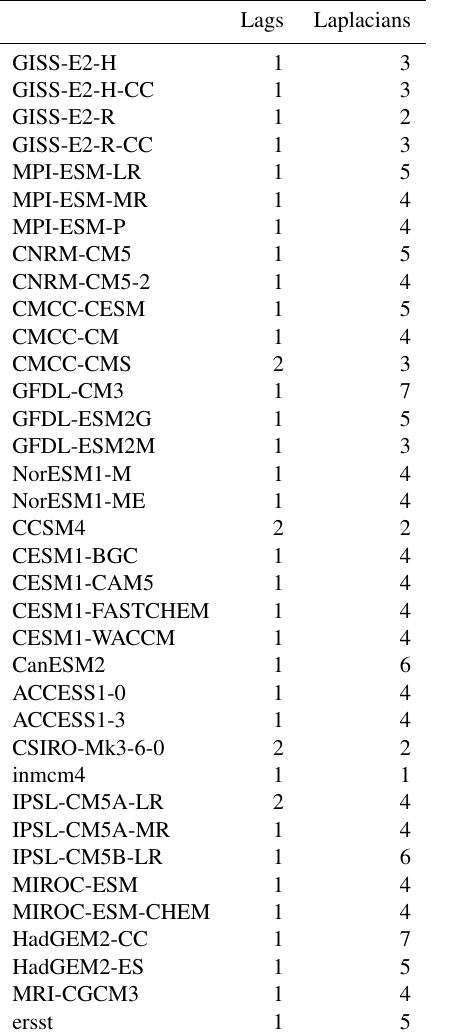
Table 1. Models selected by the MIC, based on 82-year time series from each CMIP5 control simulation.